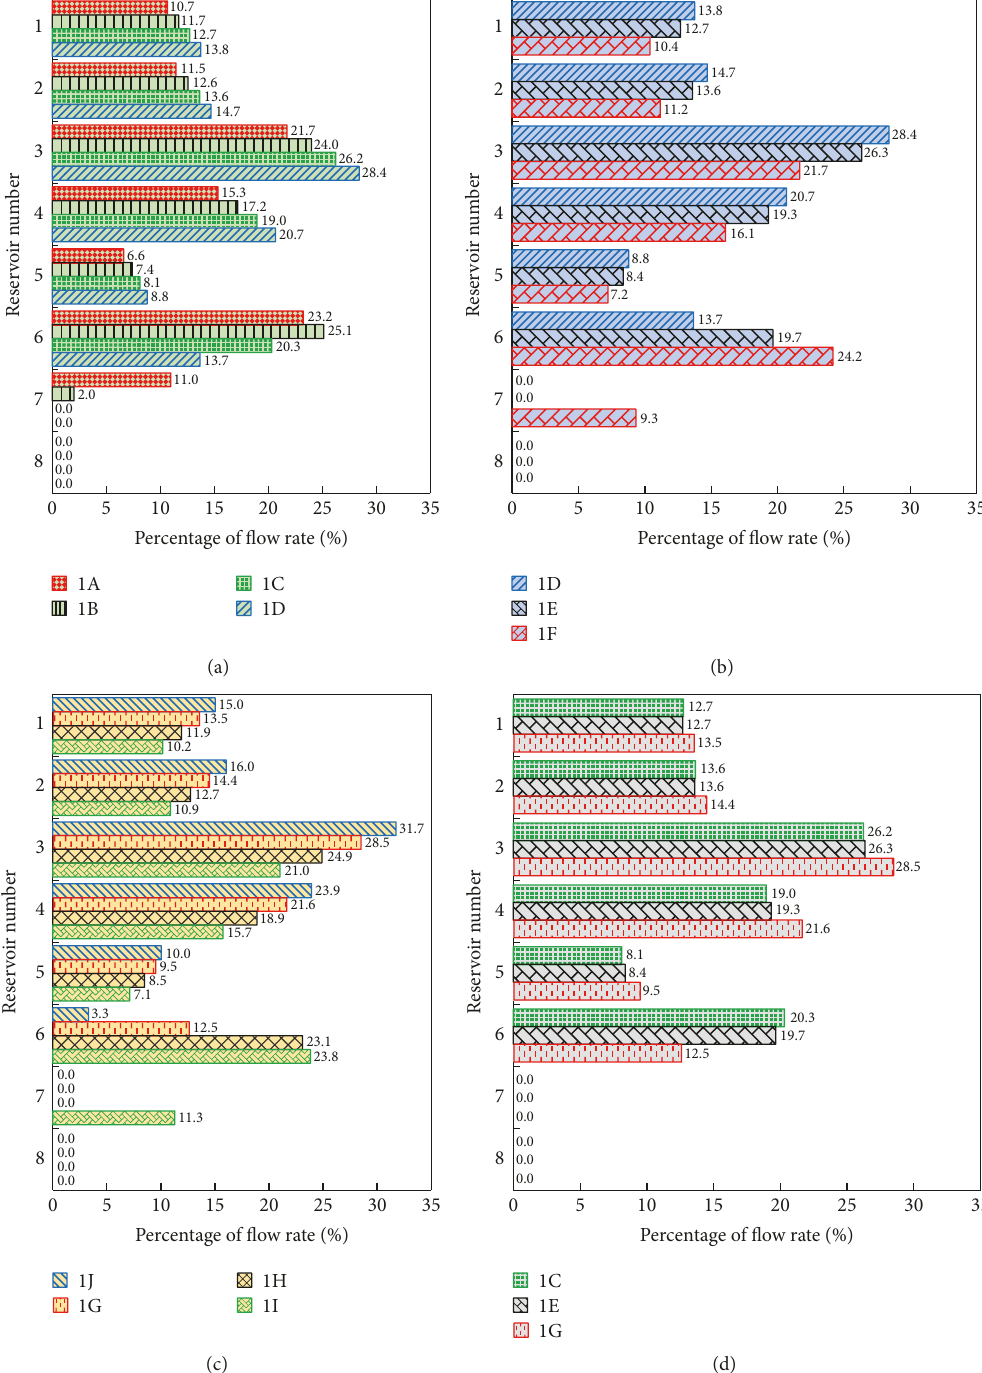
Figure 3: Distributions of the flow rates that correspond to the different injection parameters at the wellhead of the Shenhua CCS project. (a), (b), and (c) are the results for different injection pressures, flow rates, and temperatures, respectively. (d) shows the investigation of the influences of simultaneous changes of the injection pressures and flow